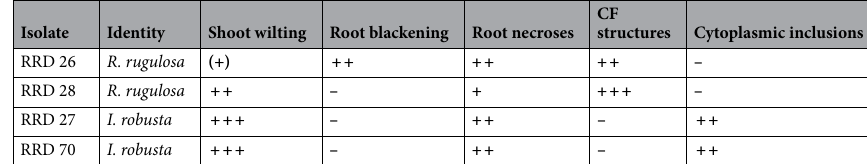
Table 2. Symptom analyses of M26 shoots and roots in a Perlite assay with temporally staggered microscopic root evaluation 4 to 52 dpi, n ≥ 4 plants, summary of symptom occurrence: – no, (+) slight, + prevalent, ++ heavy, + + + strong. Rugonectria rugulosa and Ilyonectria robusta isolates (RRD) obtained from one plant of Rosa corymbifera ‘Laxa’ after cultivation in RRD soil from the Heidgraben site and named according to the HIS gene sequence results.